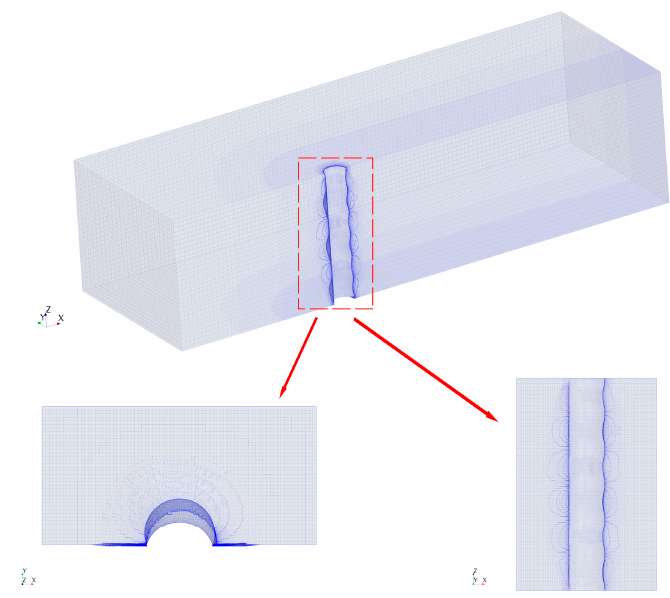
Figure 4. Mesh distributions in computational domain and near boundary layer of wavy cylinder.